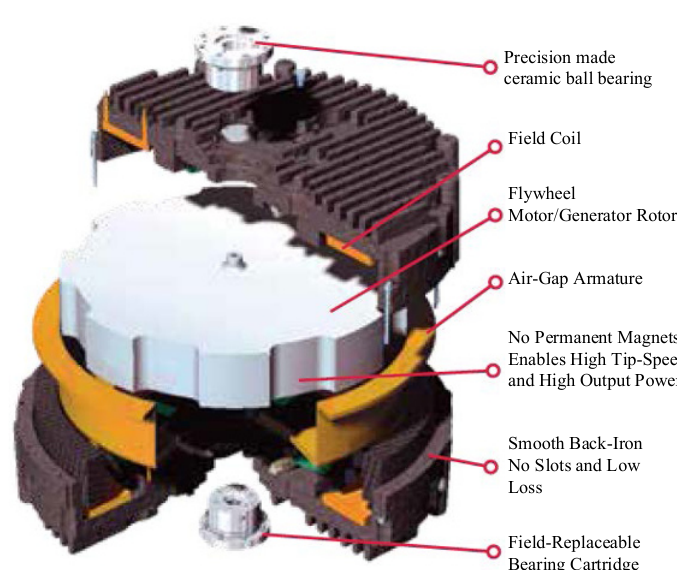
Fig. 5. UPS structure of active